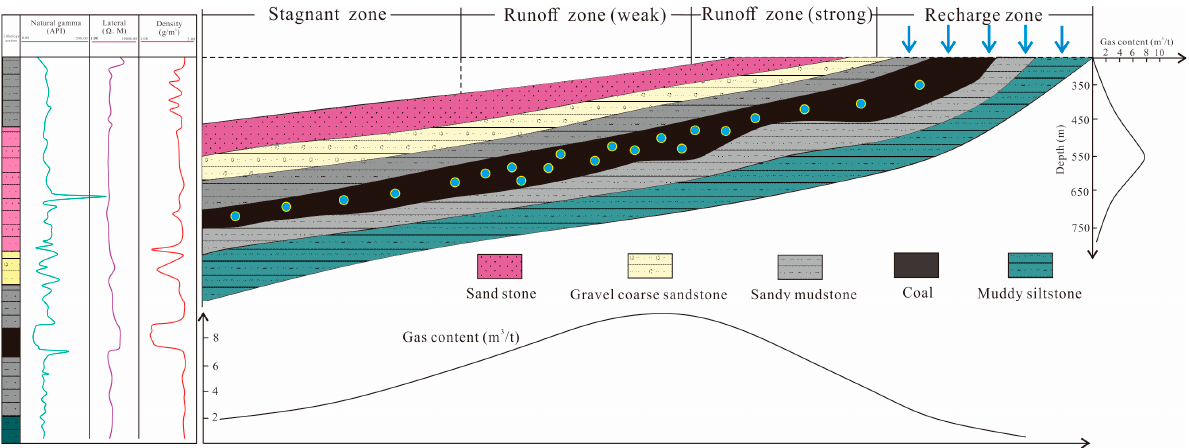
Figure 15. Geological model of CBM accumulation and enrichment.